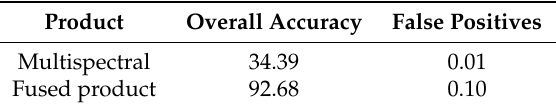
Figure 31. Detection of solar panels by hard thresholding of spectral similarity of each image element in the enhanced product (output of data fusion) and original multispectral dataset. Table 12. Performance (%) for solar panels